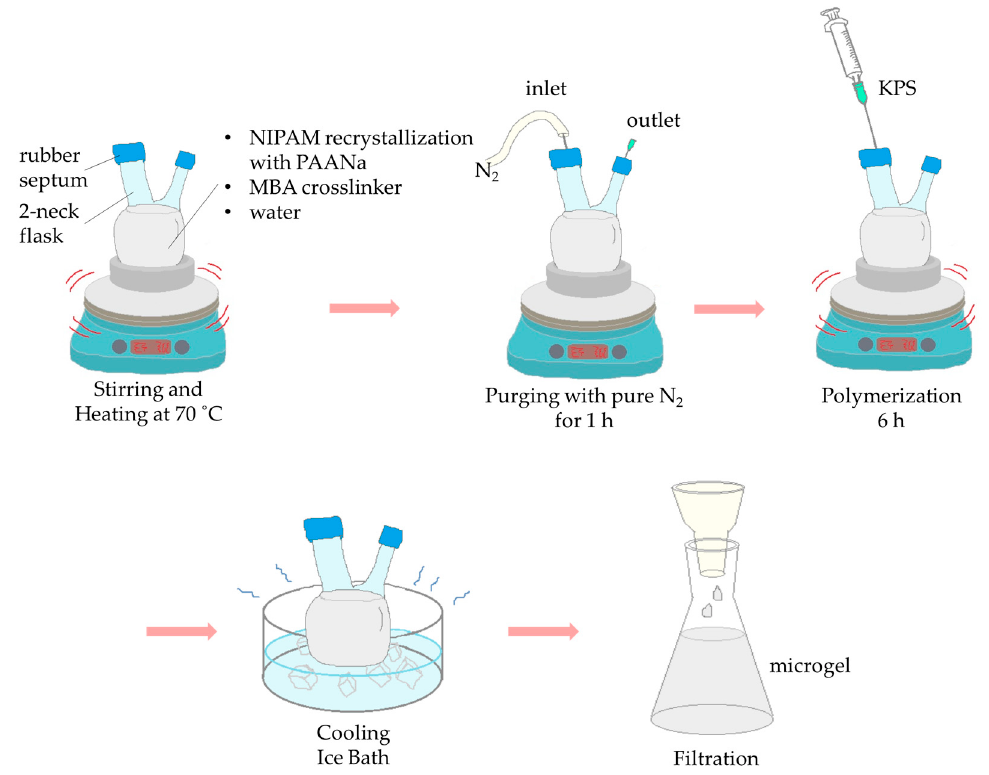
Figure 1. Schematic representation of the synthesis of PNIPAM/PAA microgel by surfactant-free precipitation polymerization.